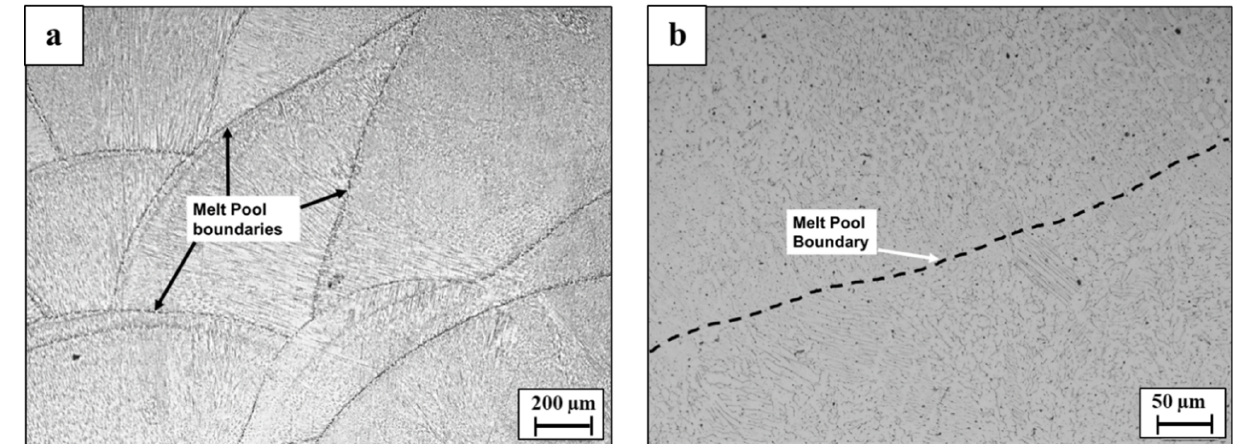
Figure 3. Microstructure of WLAM 316L alloy on XZ plane ( a , b ) showing melt pool boundaries at low and high magnifications, respectively.